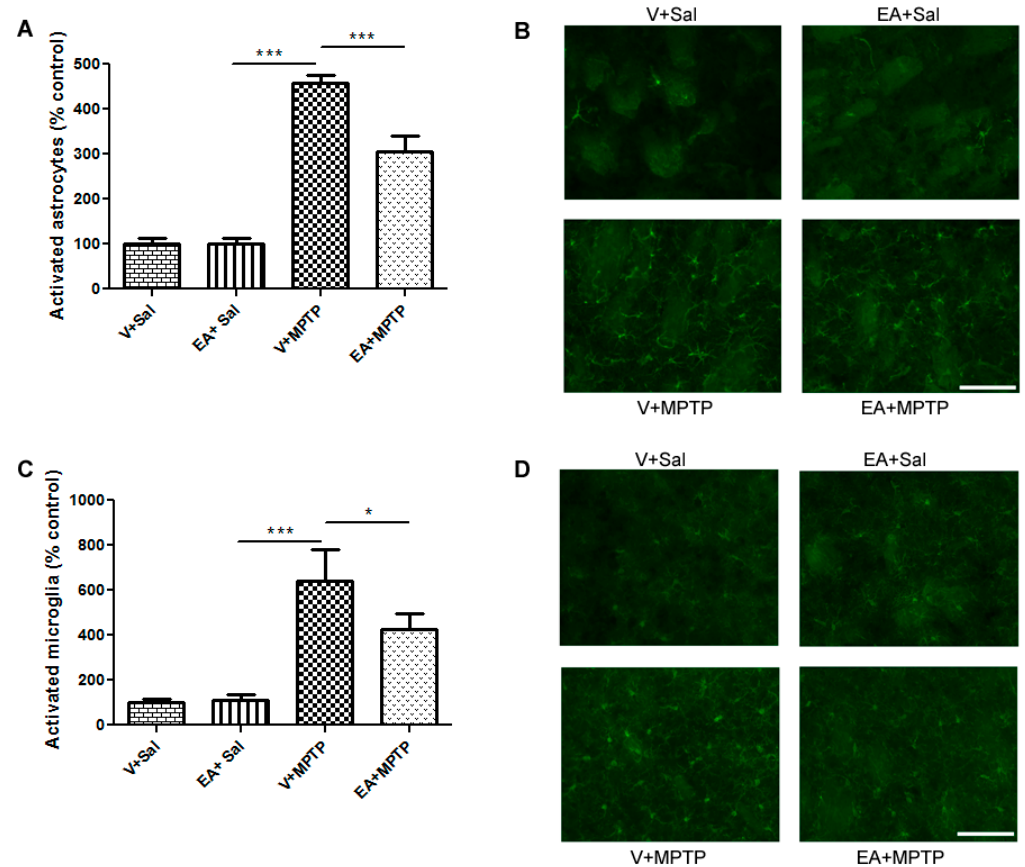
Figure 3. Immunofluorescence staining to detect the expression of activated glial fibrillary acidic protein (GFAP)-positive astrocytes (green) and ionized calcium-binding adaptor molecule-1 (Iba-1)-positive microglia (green) in the striatum of different groups of mice. Significantly higher levels of activated GFAP-positive astrocytes ( A ) and Iba-1-positive microglia ( C ) were found in the MPTP-treated mice relative to control mice (Vehicle + Saline). EA administration prior to MPTP injection in mice led to significantly lower numbers of activated GFAP and Iba-1 than MPTP-challenged mice. Quantitative analysis of activated astrocytes ( B ) and microglia ( D ) revealed a significant increase in the number of activated astrocytes and microglia in the mice injected with MPTP compared with the control mice. EA administration significantly reduced the number of activated astrocytes and microglia in the EA + MPTP group mice relative to the Vehicle + MPTP mice. Values are expressed as percentage of mean ± SEM ( n = 3–6). The scale bar is 75 µm. Significance is denoted as * p < 0.05 and *** p < 0.001.